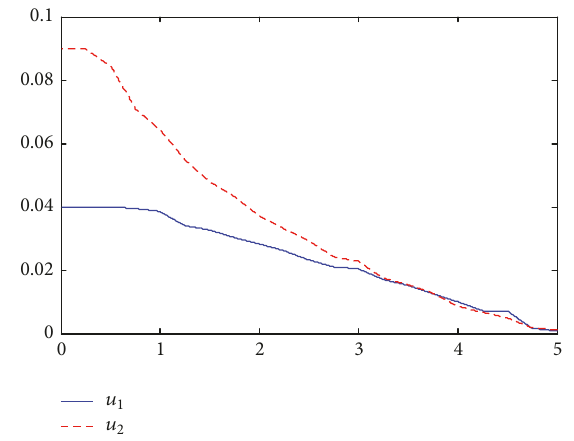
Figure 8: Optimal control for the six-plate gas absorption tower